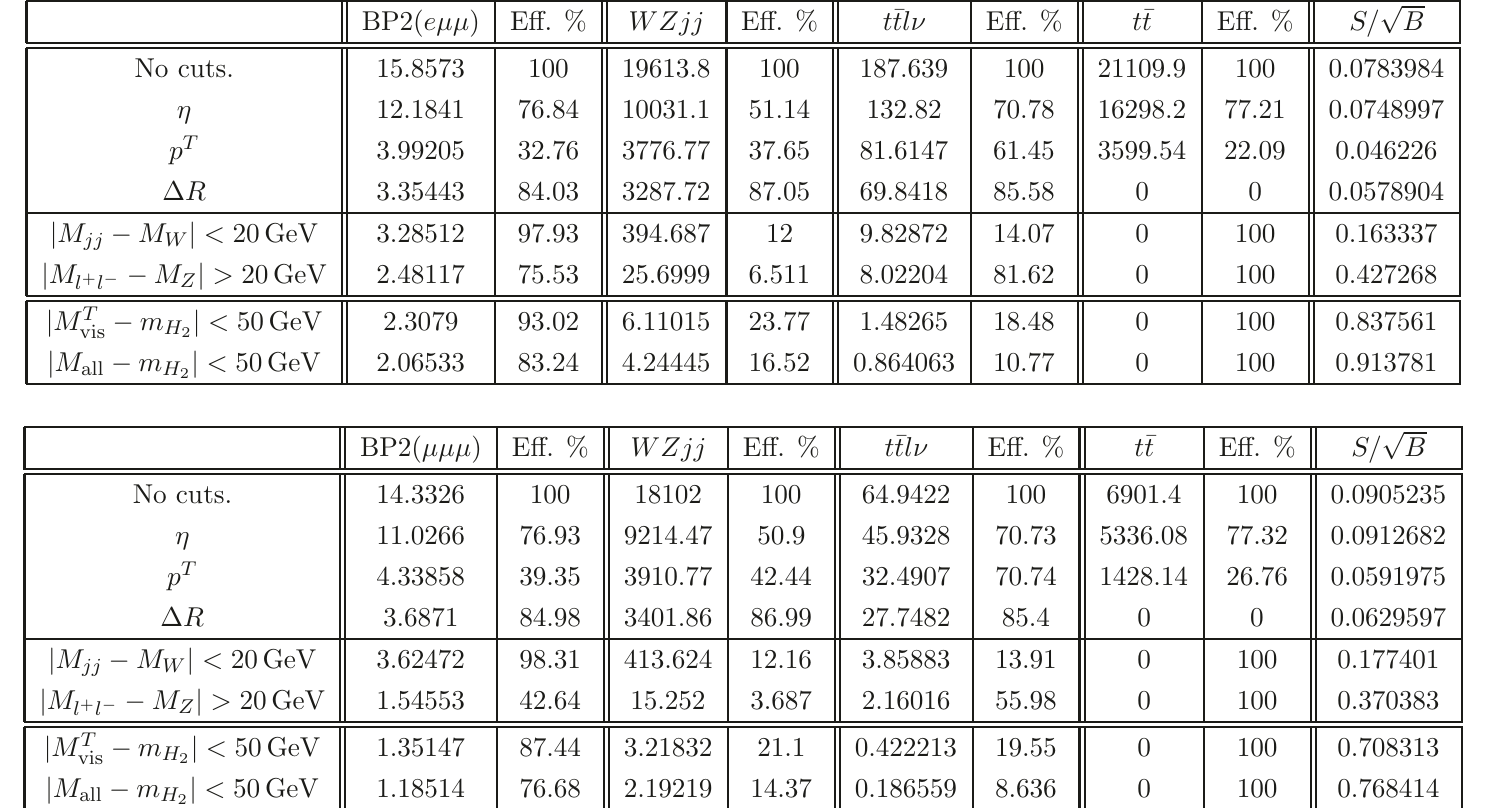
Table 5 . Benchmark point BP2. Luminosity ∆ R lj > 0 . 4 + ∆ R ll > 0 . 3. Transverse momentum cuts for the eee category: p T eeµ category: p T